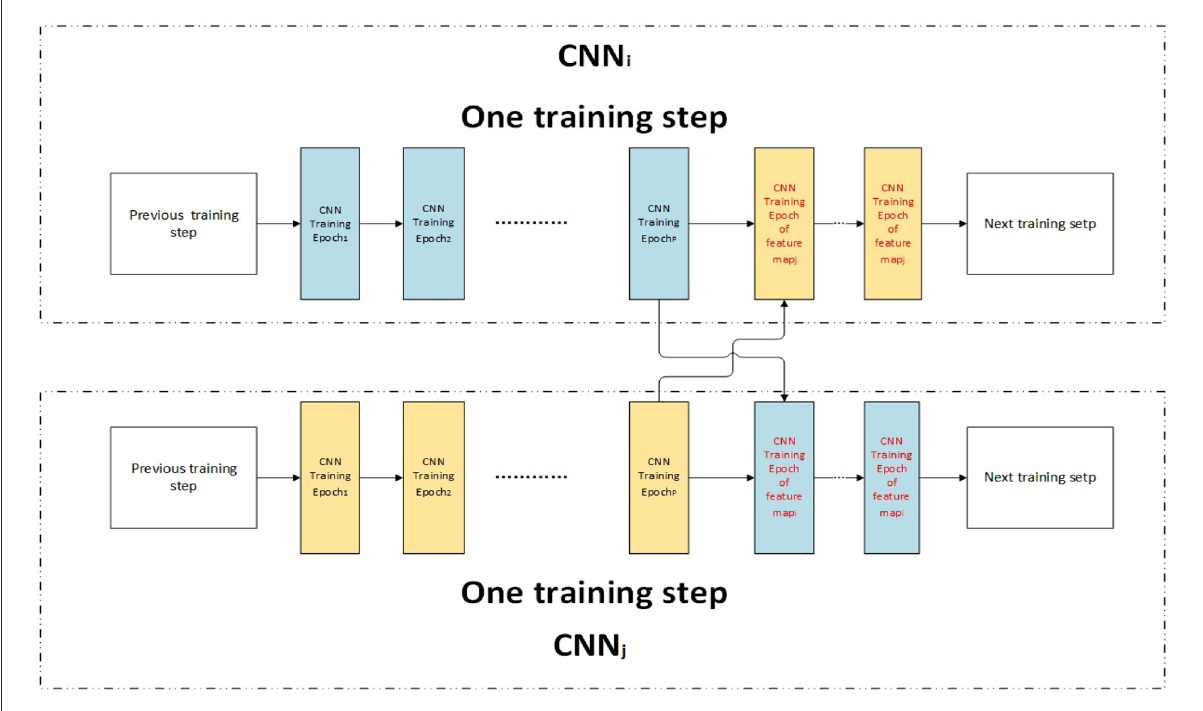
FIGURE7 Shared learning by high correlative feature